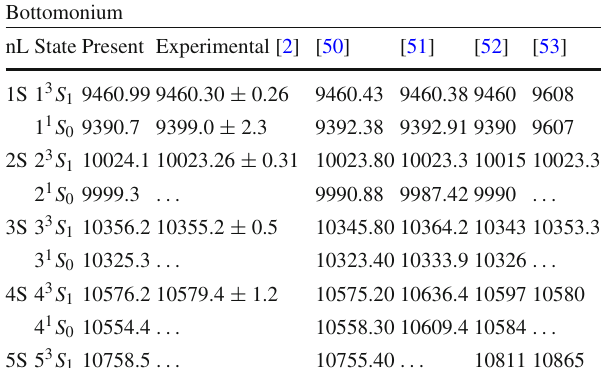
Table 4 P-wave mass spectrum for b ¯ b and c ¯ c bound states (in MeV) Bottomonium